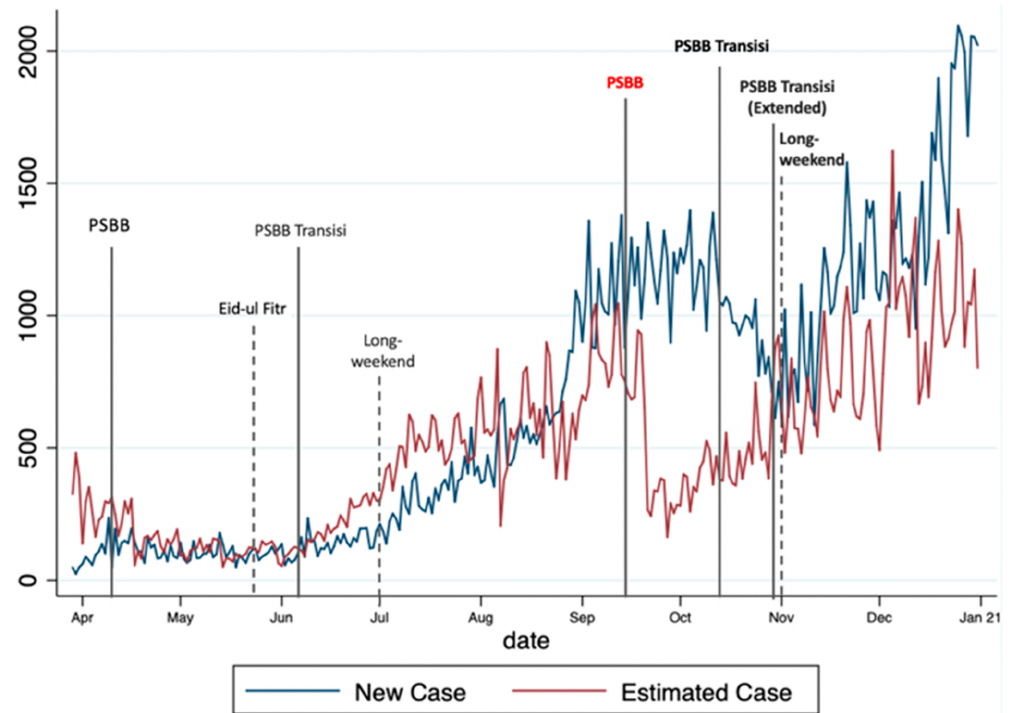
Figure 2. Observed and estimated values of COVID-19 cases.